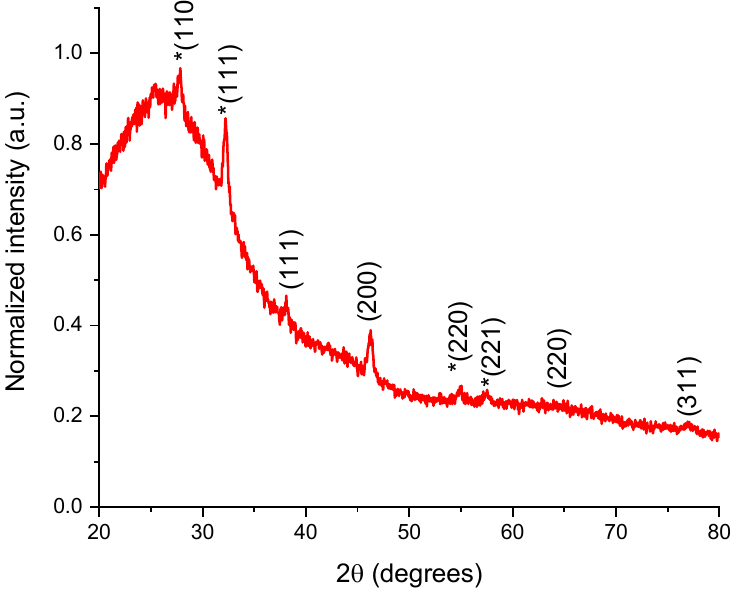
Figure 1. X-ray diffractogram of the dispersed components in the hydroalcoholic extract of D. filix-mas containing phytosynthesized silver nanoparticles. Diffraction planes of Ag 0 and Ag 2 O (silver oxide planes marked by an asterisk) with Miller indexes (hkl) are presented on the diffractogram. The present phases identification was based on the comparison with ICDD entries.